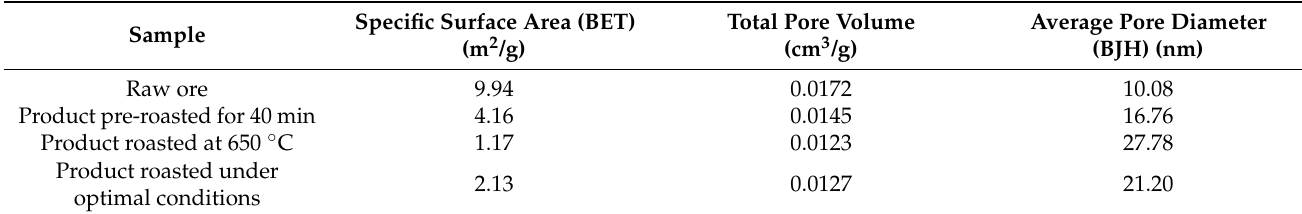
Table 6. The results of BET-specific surface area and porosity parameters of